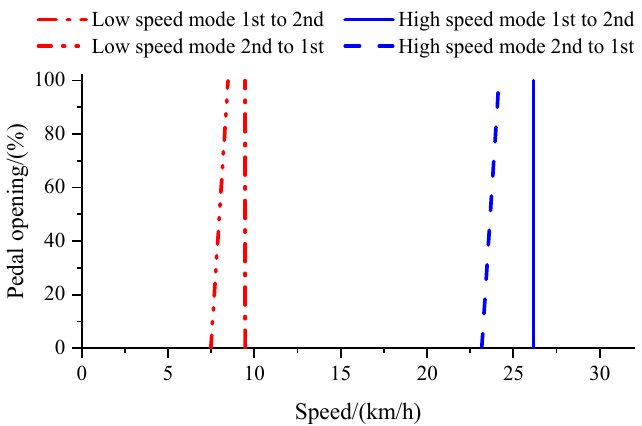
Figure 5. The optimal power shift rule curve.